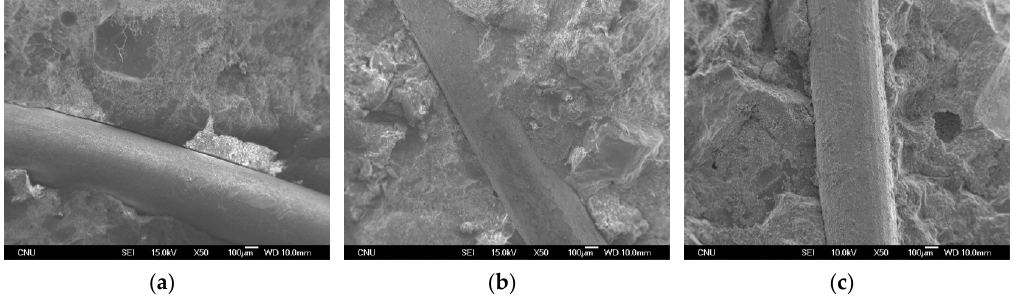
Figure 5. SEM micrographs of steel fiber–matrix transition zone. ( a ) OPC ‐ wet; ( b ) AAS ‐ dry; ( c ) AAS ‐ wet.